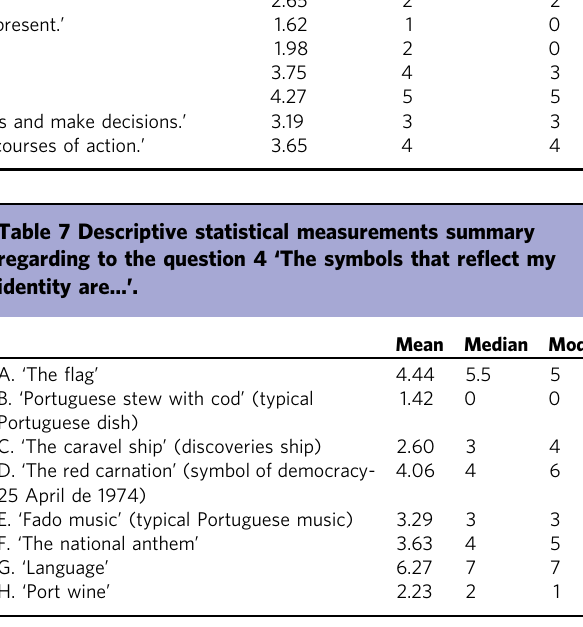
to students ’ lives. ’